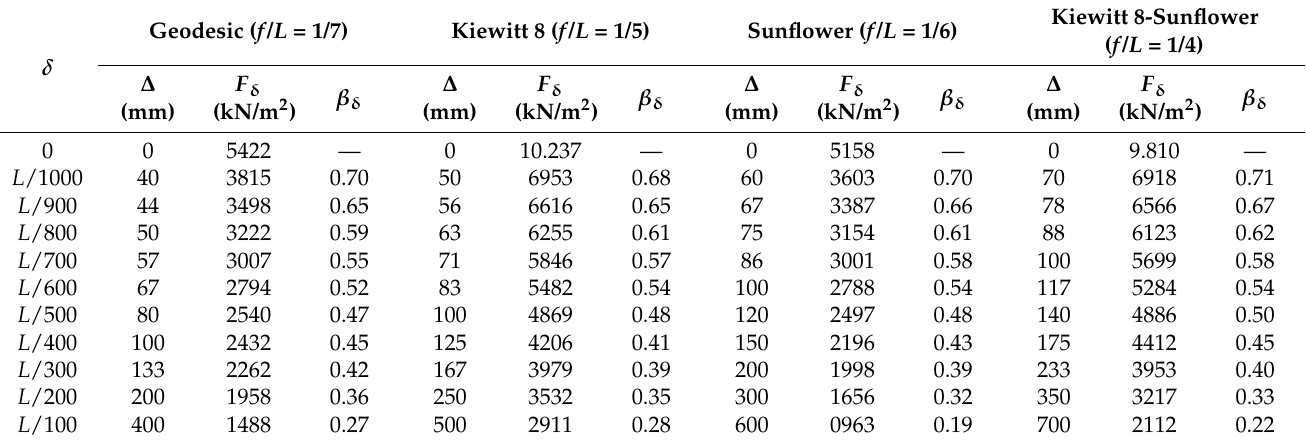
Table 2. Maximum SCL under different